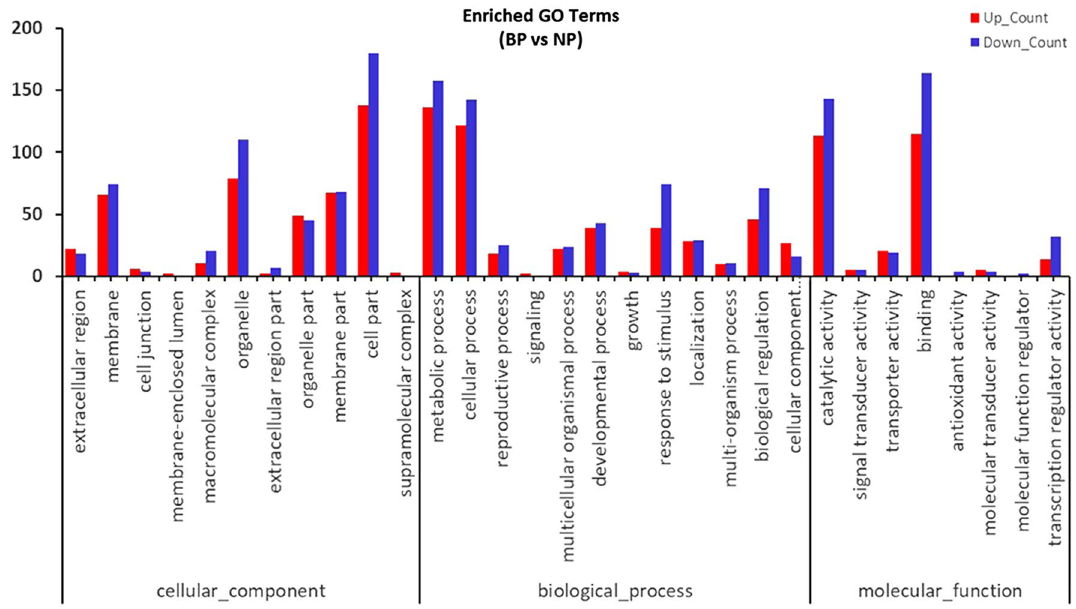
Figure 3. Enriched GO Terms of DEGs generated from the bolting plant (BP) and normal plant (NP)